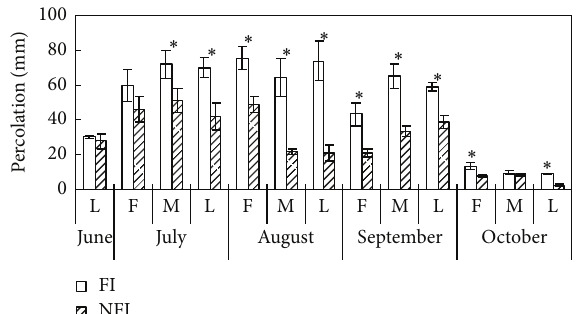
Figure 5: Percolation volumes from paddy soils under different irrigation managements ( ∗ indicates difference between NFI and FI that is significant at 𝑃 < 0.05 ).